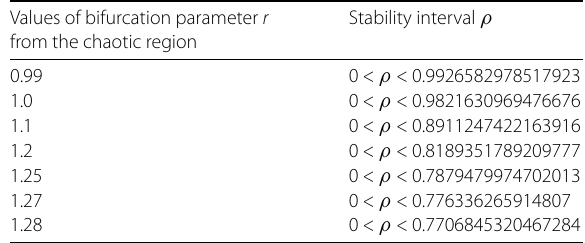
Table 1 Controllable interval for system (35) with various values of r in the chaotic region Values of bifurcation parameter r Stability interval ρ from the chaotic region 0.99 0 < ρ <